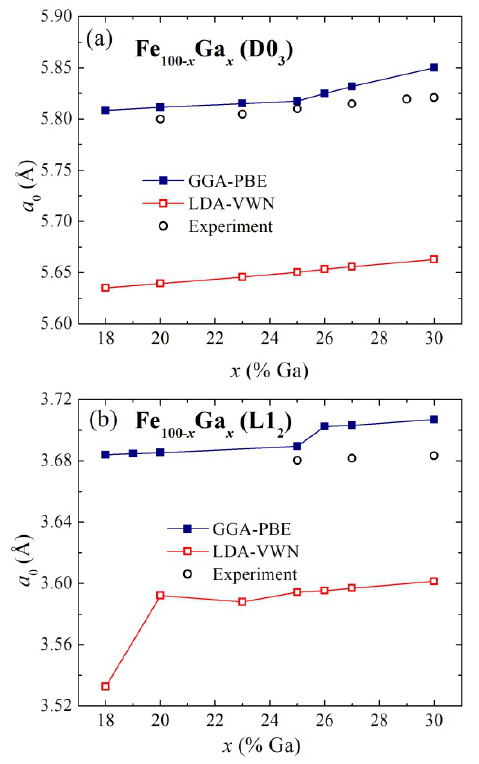
Fig. 1. The calculated equilibrium lattice parameter ( a 0 ) as a function of Ga concentration ( x ) for the (a) D0 3 and (b) L1 2 structures of Fe 100- x Ga x alloys in comparison with experimental data. The experimental data were taken from [22]. Our calculation have shown that for both D0 3 and L1 2 structures, lattice constant increases with increasing Ga concentration. For both bcc and fcc structures, the results obtained within the GGA-PBE approximation are in the better agreement with the experimental data than those obtained for the LDA-VWN